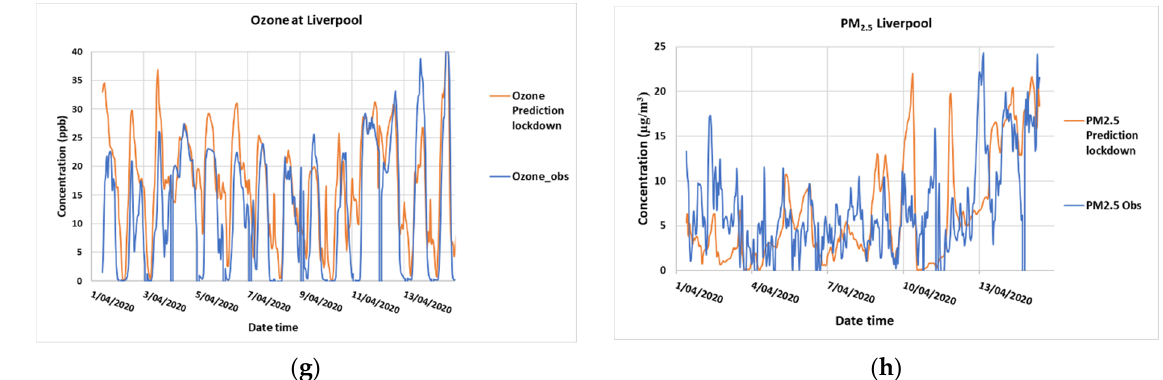
Figure A2. CO, NO 2 , O 3 , and PM 2.5 prediction from 1 to 14 April 2020 at ( a – d ) Rozelle and ( e – h ) Liverpool during the lockdown, as compared with the observation. The predicted PM 2.5 consists of the following subcomponents: PM25_EC (elemental carbon), PM25_OC (organic carbon), PM25_OM (organic matter), PM25_CL (chlorine), PM25_MG (manganese), PM25_NO3 (nitrate), and PM25_NH4 (ammonium) as defined in the CMAQ model.